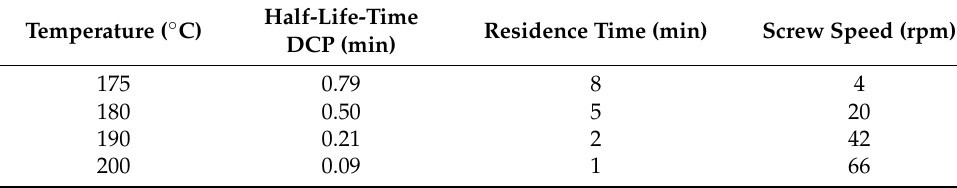
Table 3. Half-life-time DCP at different